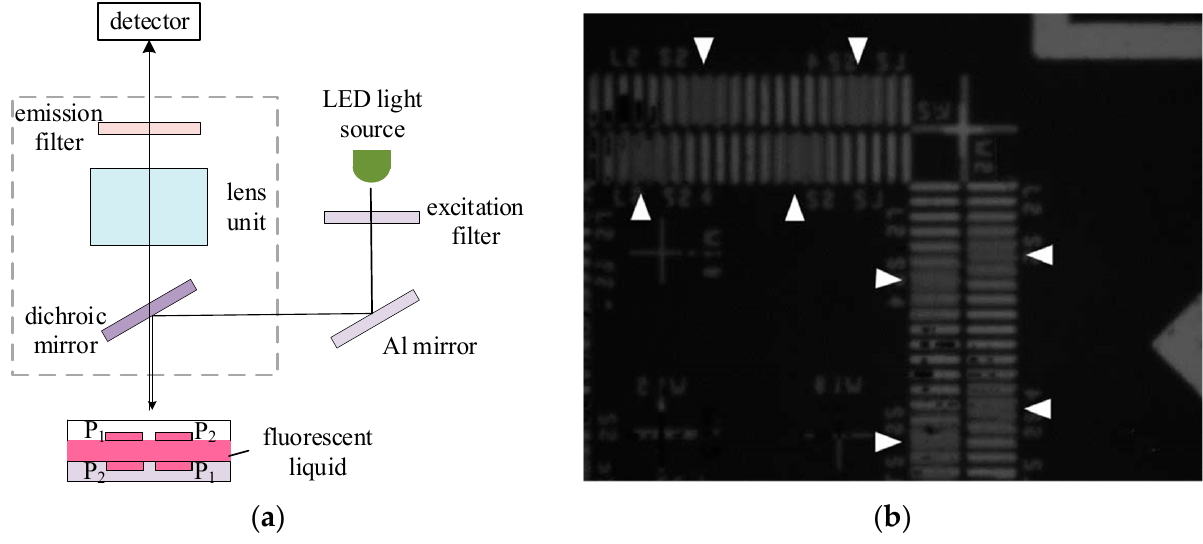
Figure 8. Fluorescent Moir é fringe alignment. ( a ) Alignment system schematics. ( b ) Moir é fringe image. In this method, the excitation of the fluorescent liquid functions as a light source to generate gratings superimposed to form additive fluorescent Moir é fringes. When periods P 1 and P 2 are 4.0 and 4.4 µ m, respectively, and the width of the filled fluorescent liquid is 2.0 µ m, the fluorescent Moir é images with excellent contrast and visibility. Corrections of angular displacements from 0.44 ◦ and 72.09 ◦ to 0 ◦ were achieved. In in-plane axial displacement correction, the team demodulated the resulting high-frequency signal and achieved an axial correction with a deviation of 5.9 nm [42]. The uniformity of the residual layer formed by the liquid sandwiched between the mold and the substrate surface can be observed, and its thickness can be